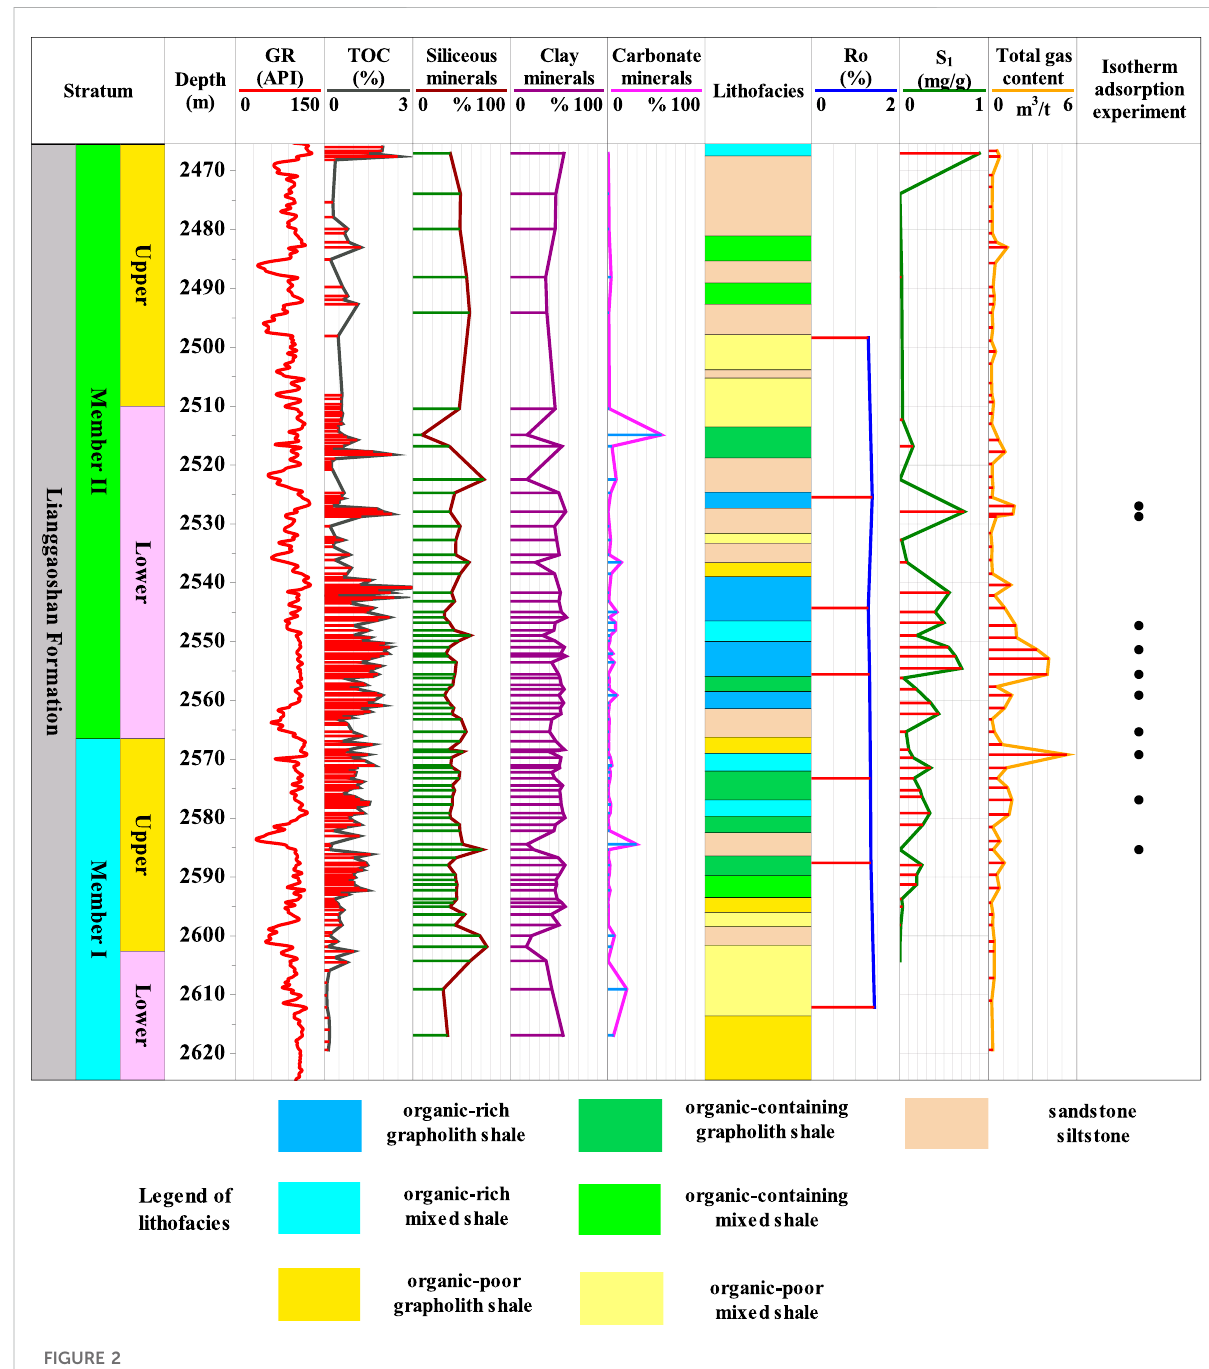
FIGURE 2 Comprehensie histogram of sampling depth, analysis and test results of the samples, and lithofacies division results in Member I and Member II of Well TYX. Modi fi ed from references (Liu W. et al., 2021; Wei et al., 2021; Zhang et al., 2022b). See Figure 1 for the well location.